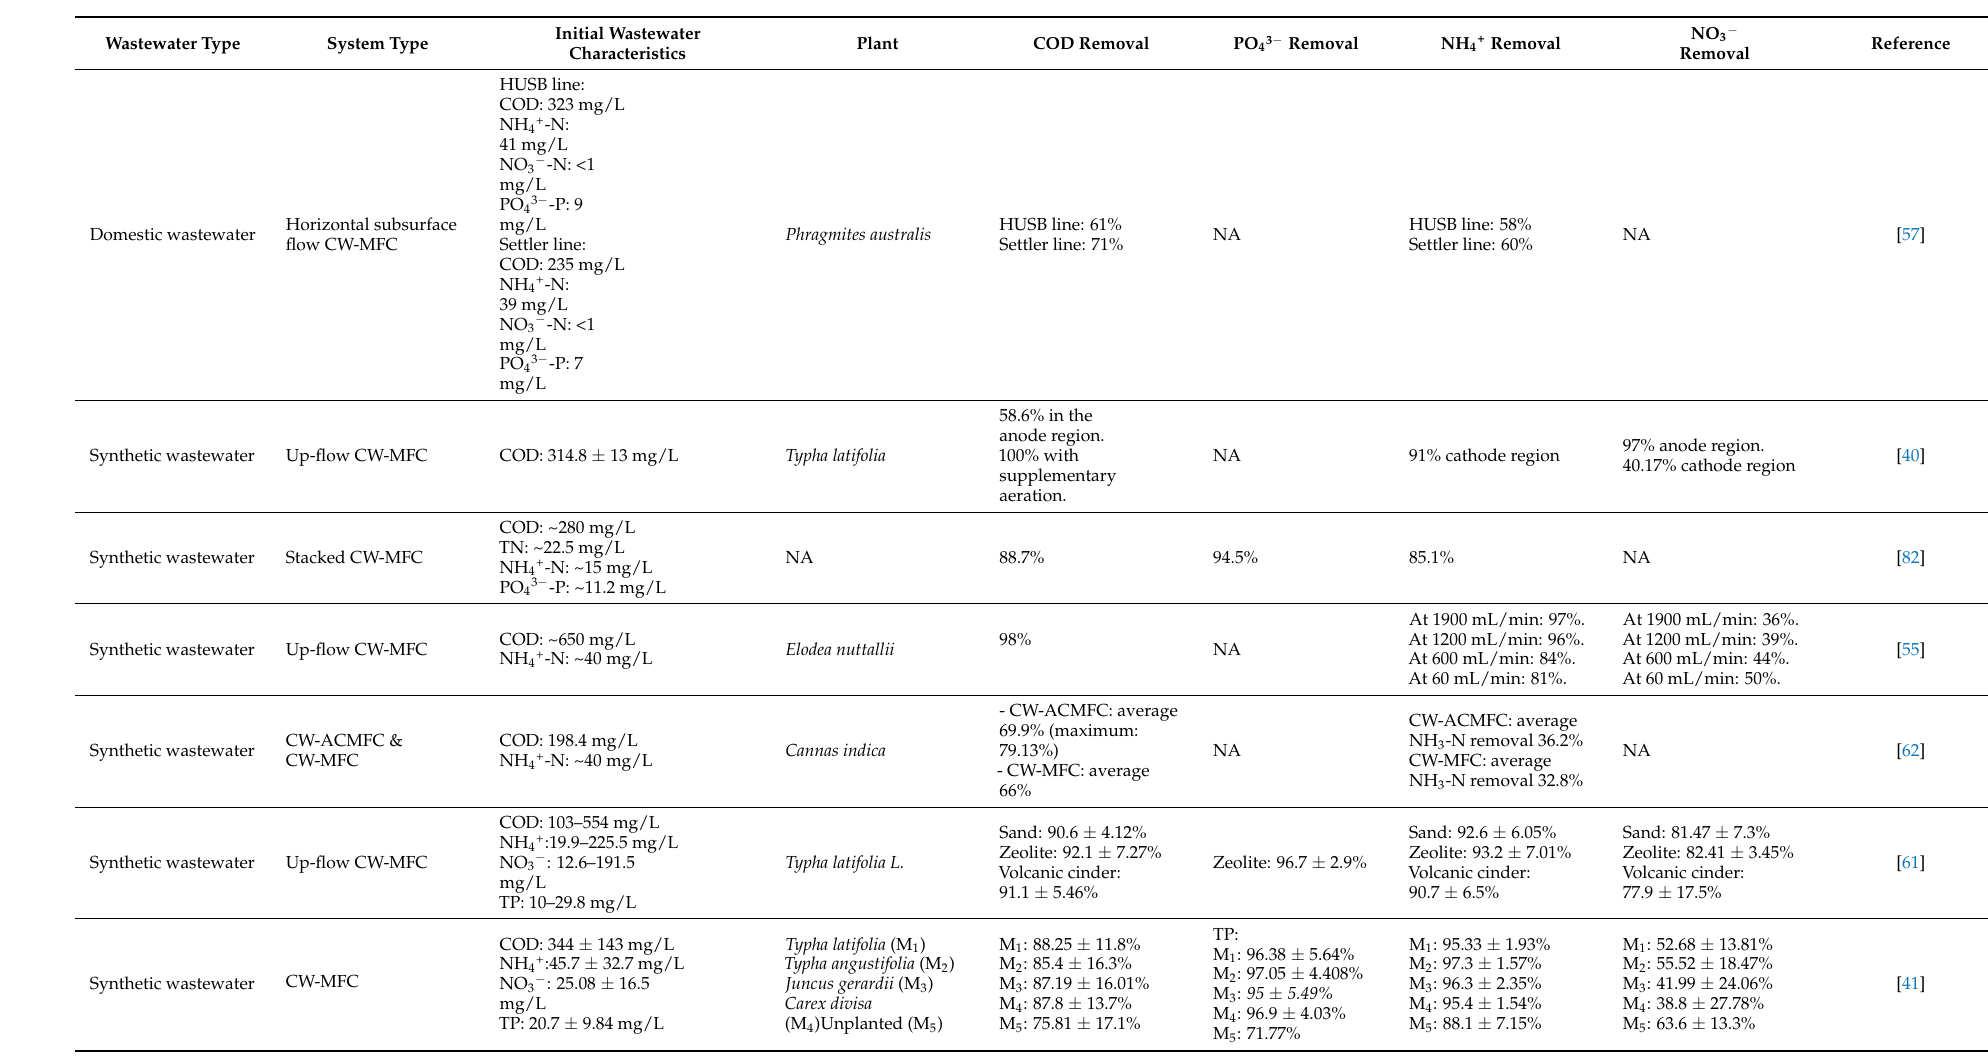
Table 2. Nutrient removal in the Hyp-MFC and CW-MFC